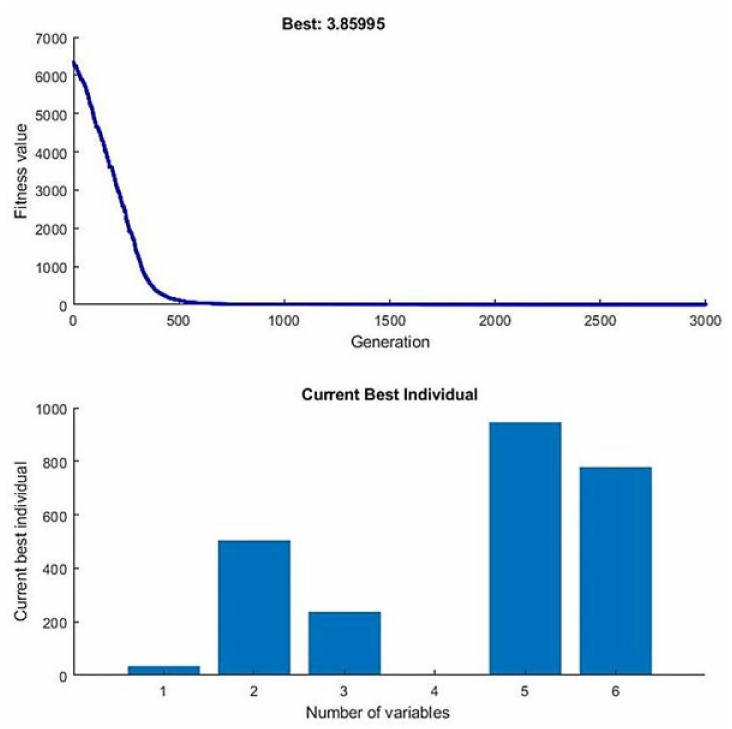
Figure 4. Results of optimization by means of the genetic